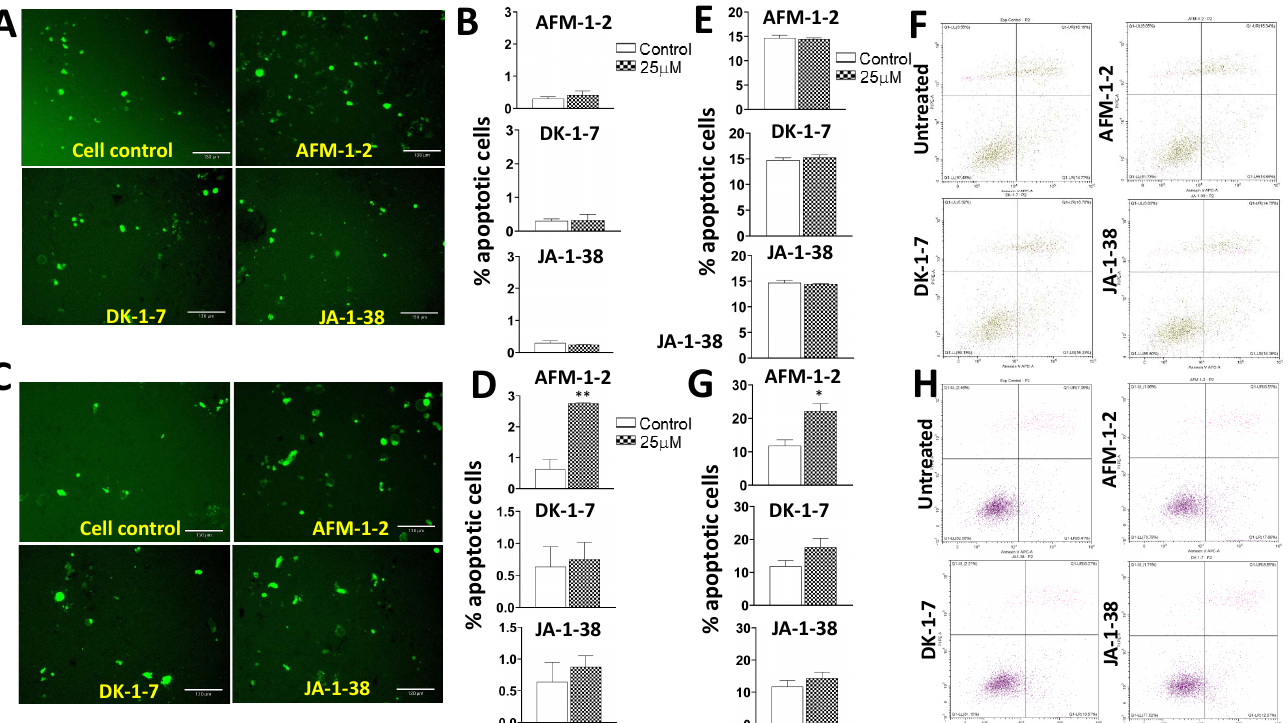
Figure 7. An increase in apoptosis was detected in Hep3B cells treated with AFM-1 and -2. ( A ) Mi- croscope images of Apotracker Green-stained HepG2 cells treated with AFM-1 and -2, DK-1–7, and JA-1–38. ( B ) Percentage of apoptotic cells stained by Apotracker Green in HepG2 treated with AFM-1 and -2, DK-1–7, and JA-1–38. ( C ) Microscope images of Apotracker Green-stained Hep3B cells treated with AFM-1 and -2, DK-1–7, and JA-1–38. ( D ) Percentage of apoptotic cells stained by Apotracker Green in Hep3B cells treated with AFM-1 and -2, DK-1–7, and JA-1–38. The treatment with AFM-1 and -2 resulted in a significant increase in apoptosis compared to the control cells ( p = 0.002). ** = p < 0.01. ( E ) Percentage of apoptotic cells evaluated by Annexin V-APC/PI staining in HepG2 cells. Data are presented as the mean percentage of measured apoptotic cells. ( F ) Representative dot plots of HepG2. ( G ) Percentage of apoptotic cells evaluated by Annexin V-APC/PI in Hep3B cells. Data are presented as the mean percentage of measured apoptotic cells. The treatment with AFM-1 and -2 resulted in a significant increase in apoptosis compared to the control cells ( p = 0.022). * = p < 0.05. ( H ) Representative dot plots of